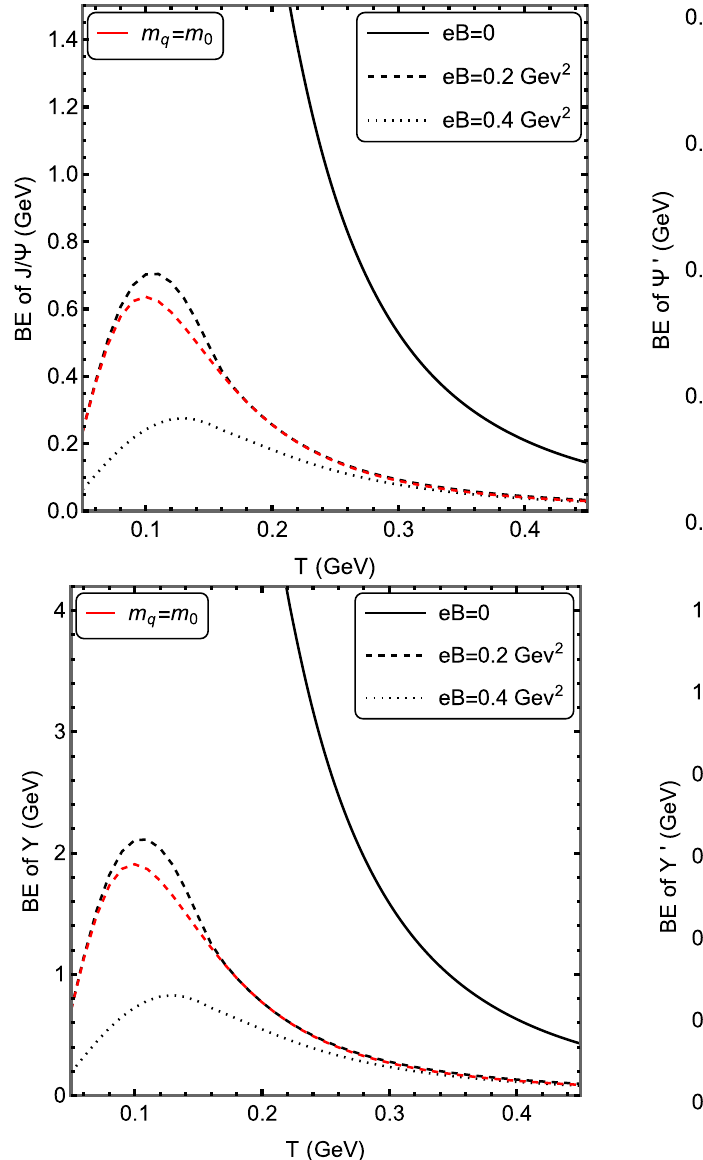
Fig. 6 Variation of binding energy (in GeV) with temperature with different values of magnetic field (eB) for ψ (cid:10) (left panel) and ϒ (cid:10) (right panel)